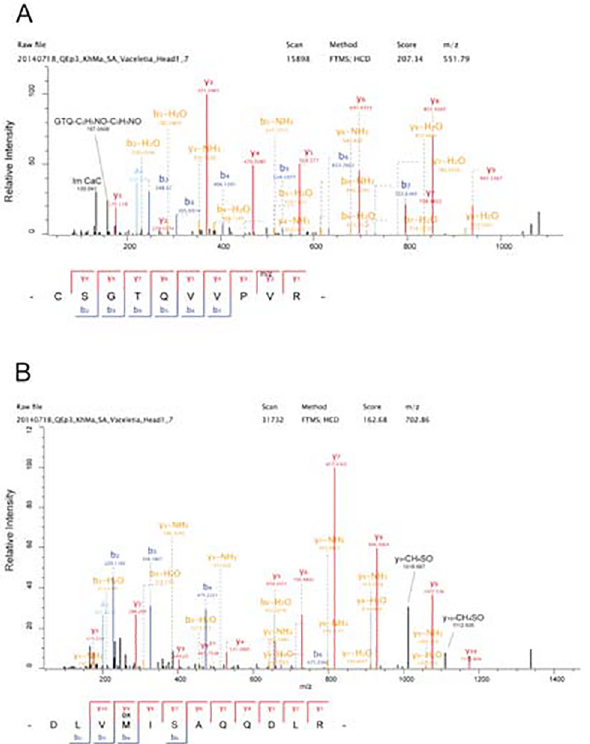
Fig 3. Selected spectra of single sequence-unique peptide identifications. Y-ions are shown in red, b- ions in blue, a-ions in light blue, b- and y ions showing loss of water or ammonia are shown in orange, ions annotated with the help of the MaxQuant Expert System are shown in black. (A) peptide of entry c102844_g1_i1_3. Two fragments annotated with the help of the Expert system are the immonium ion of carbamidomethylated cysteine (Im CaC) and an internal fragment at m/z 157.0508 derived from the tripeptide GTQ. (B) peptide of entry C41414_g3_i1_2. Ions y10 and y9 show the loss of CH 4 SO typical for oxidized methionine residues